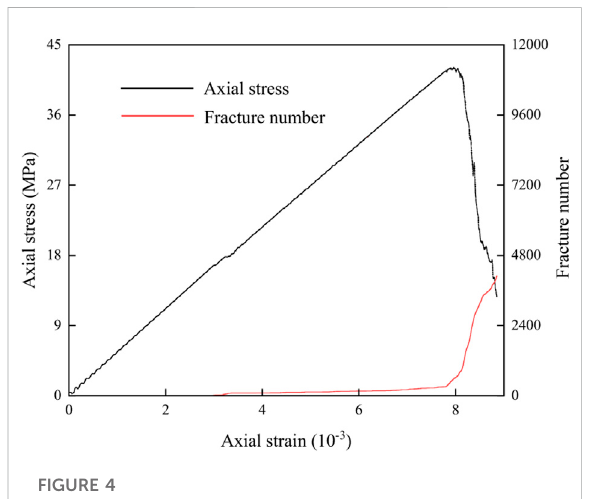
FIGURE 4 Complete rock stress-strain curve and fracture number- strain curve.